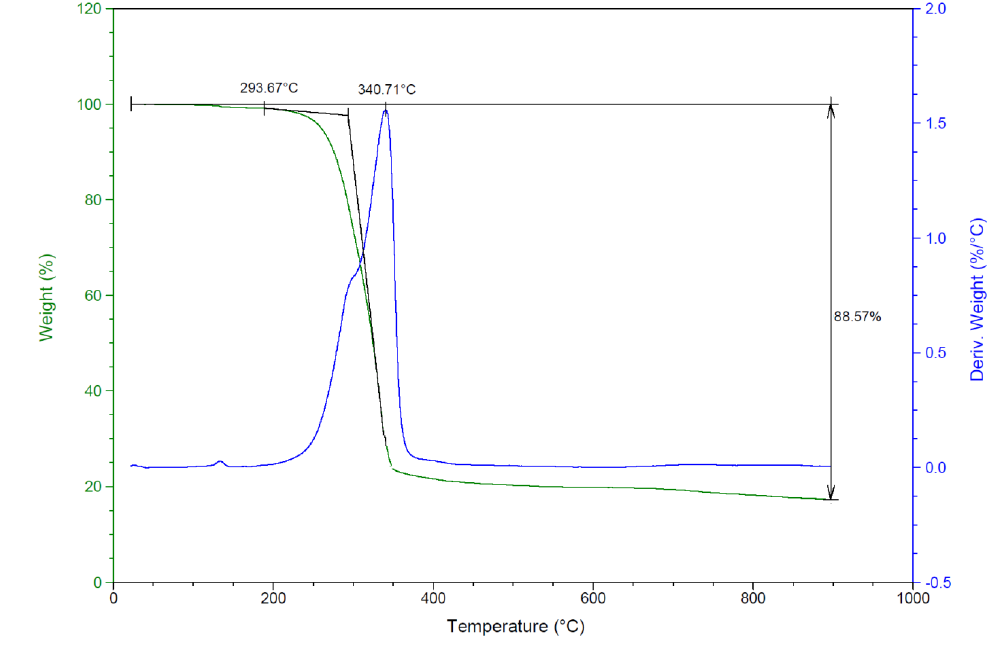
Figure 7. TG and DTA thermal curves of complex 1